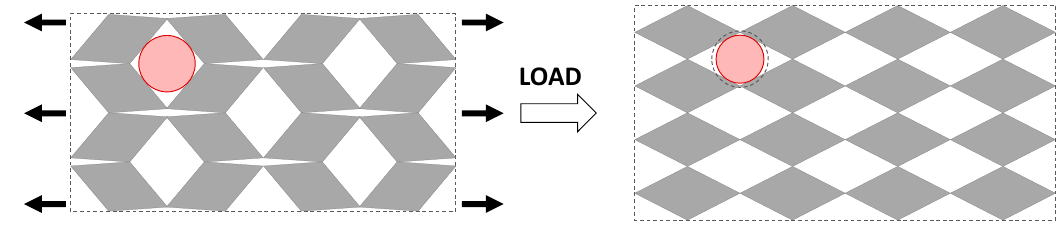
Figure 4. A rotating rhombi network behaving auxetically on stretching while the pore radius decreases.